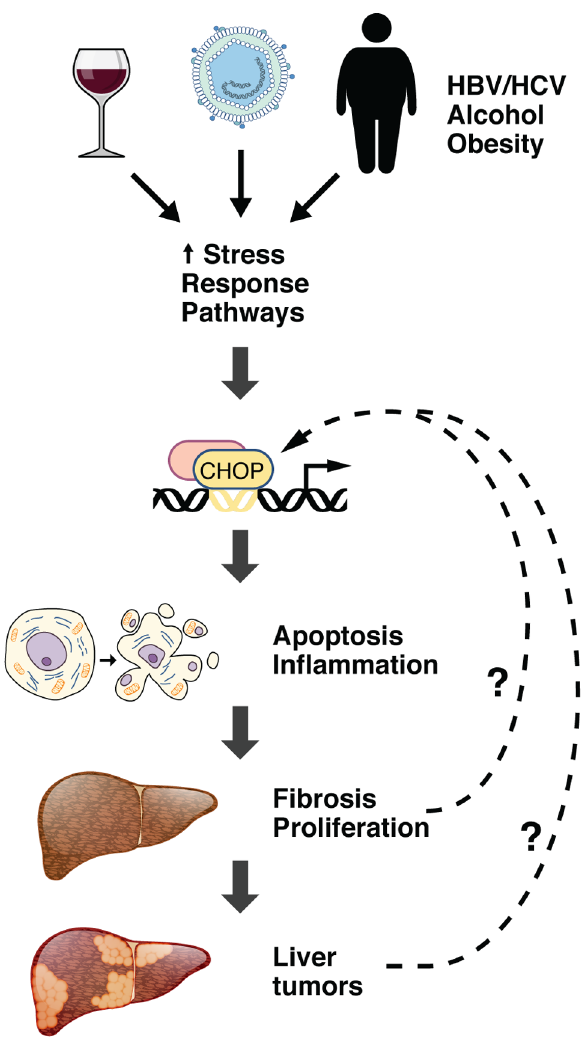
Figure 1. The role of CHOP in HCC pathogenesis. Hepatocyte injury, including toxicity from viral hepatitis, obesity, or alcoholism, promotes the induction of canonical ER stress pathways, including the UPR and ISR. This results in induction of the CHOP transcription factor, which stimulates cell death and provokes an inflammatory response. Inflammation may further stimulate fibrosis and compensatory proliferation, leading to the development of liver tumor nodules. It is also possible that stress caused by fibrosis and proliferation of dysplastic hepatocytes in HCC may induce expression of CHOP, further amplifying its effect on